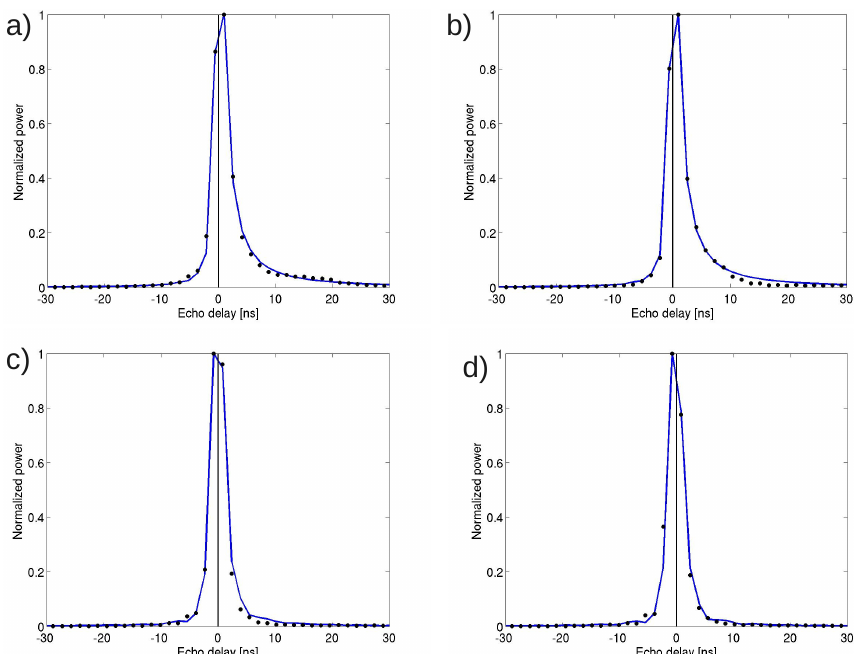
Figure 6. Example CryoSat-2 waveform fits for sea ice leads with increasing values for α . The fitted waveform at the instrument sampling resolution is shown in blue, and the CryoSat-2 data points are represented by black dots. (a) α = 5 . 1 × 10 5 , σ = 0 . 01m. (b) α = 2 . 7 × 10 6 ,